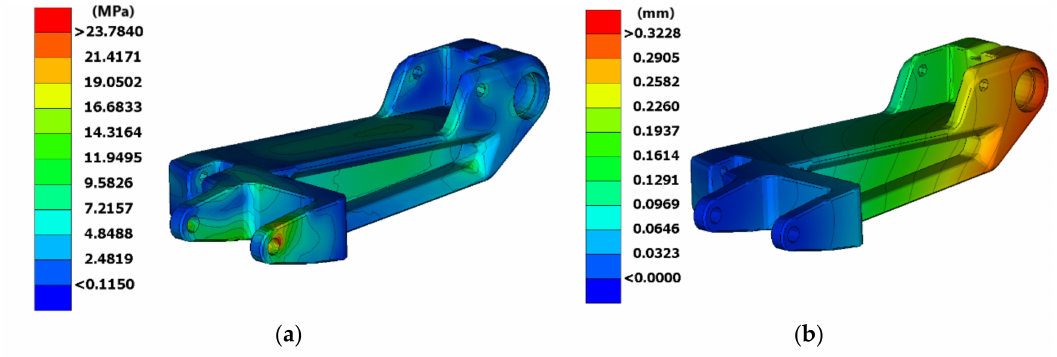
Figure 9. Stress ( a ) and displacement ( b ) results in 1st loading scenario.